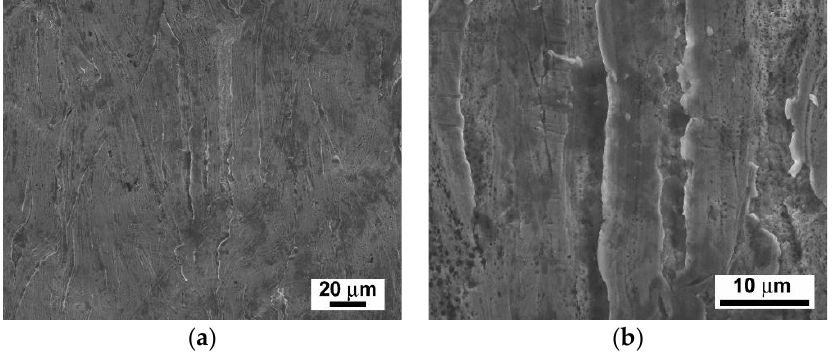
Figure 13. Typical surface degradation of hydrogenated tensile test specimen after cathodic hydrogen charging of studied 316H material visualized by SEM at: ( a ) lower magnification and ( b ) higher magnification.